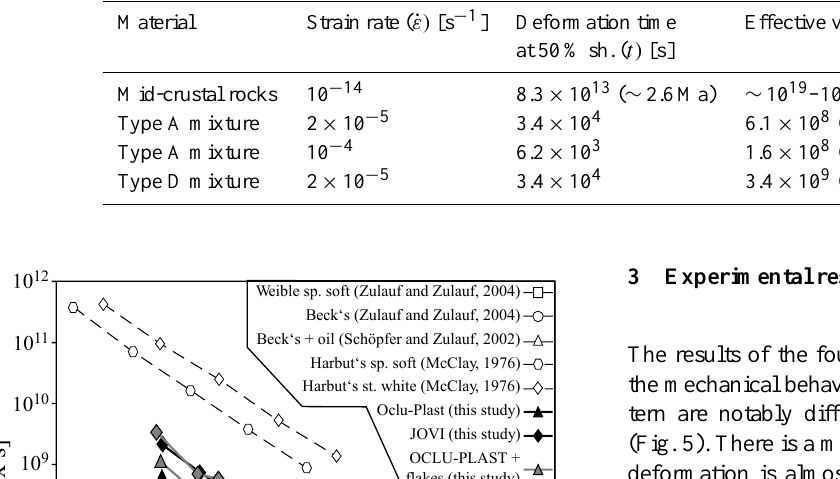
Table 3. Values of strain rate and effective viscosity of mid-crustal rocks and the less and more viscous analogue materials used in this study (Types A and D mixtures respectively). The strain rate value for mid-crustal rocks was taken from Pfiffner and Ramsay (1982) and Weijermars (1997). The viscosity of schists was taken from Talbot (1999) and Davidson et al. (1994).